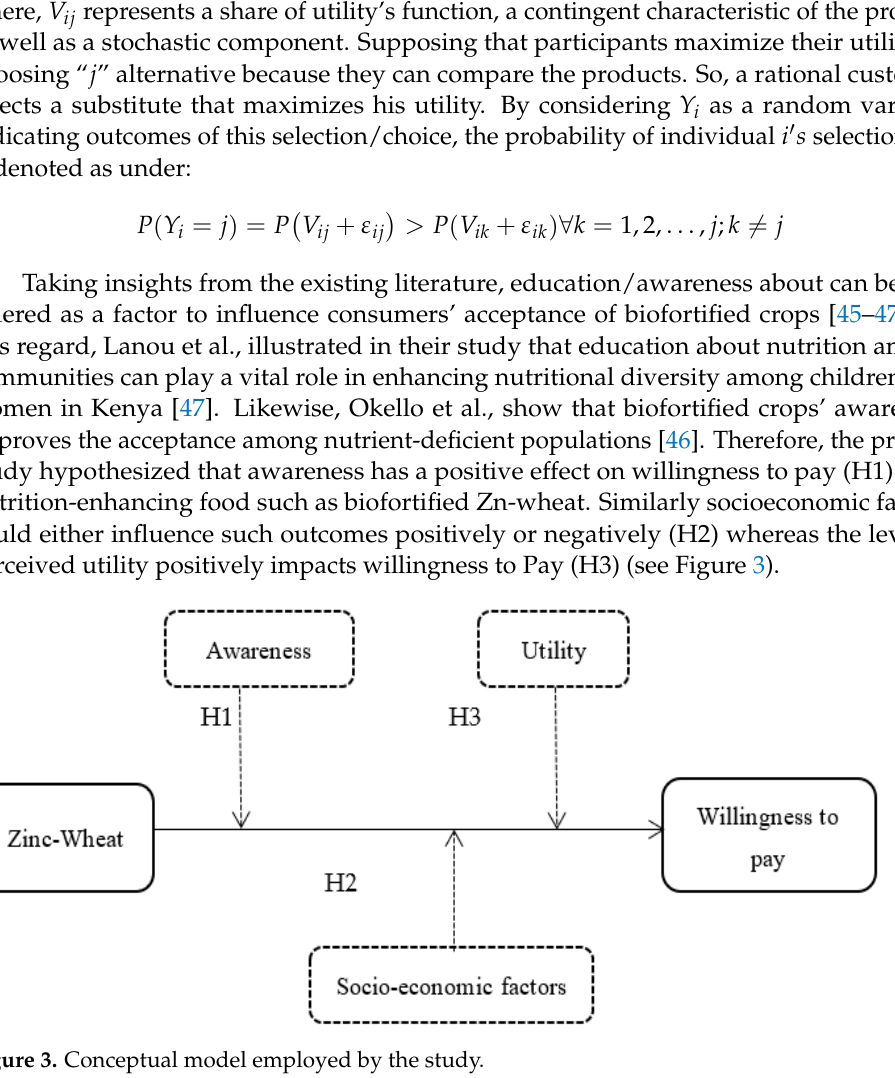
Figure 3. Conceptual model employed by the